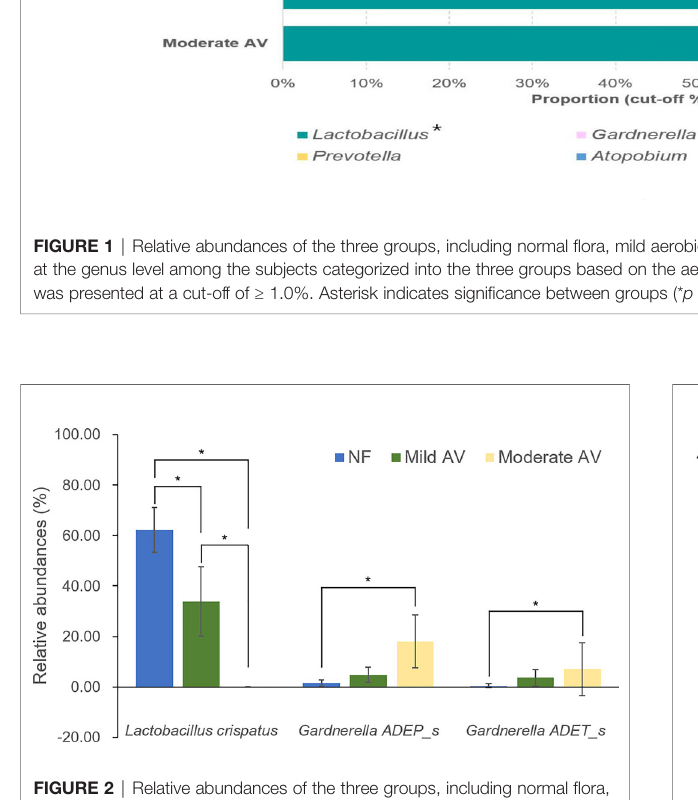
FIGURE 2 | Relative abundances of the three groups, including normal fl ora, mild aerobic vaginitis, and moderate aerobic vaginitis. Average taxonomic compositions at the species level among the subjects categorized into the three groups based on the aerobic vaginitis scoring system. The proportion of the bacterial composition was presented at a cut-off of ≥ 1.0%. Error bars indicate 95% con fi dence intervals. Asterisk indicates signi fi cance between group (* p < 0.05) as determined using the Kruskal – Wallis test.